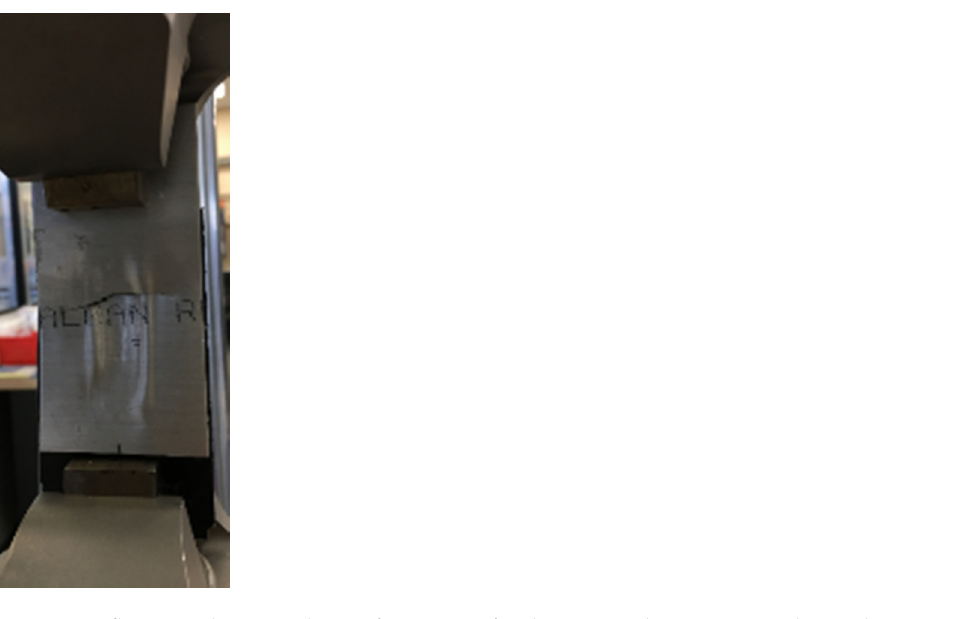
Figure 15. Quasi-static lap shear typical curves comparison between joints of 5182/FRPC (insert DC04) and MPS welded 5182/DC04 joints under the same conditions. 3.2. Configuration with Metallic Patch: Principle Feasibility Validation The first patch used was a 5754 aluminum patch of 50 × 40 mm² having a thickness of 0.5 mm. The hole in the composite is a rectangular hole with a width of 25 mm and a height of 50 mm and the coil is a linear copper coil [53]. The configuration was tested on both a DC04 steel and a DP450 steel with discharge energies of 10 kJ, 13 kJ and 16 kJ in both cases. The welding occurred in the three cases and for both types of steels (Figure 16).